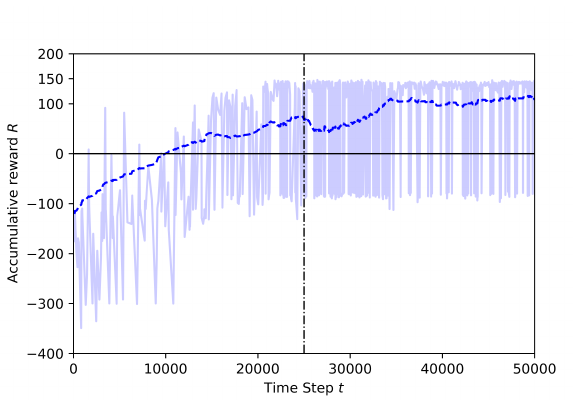
Figure 15. Training result for Case 1.3.